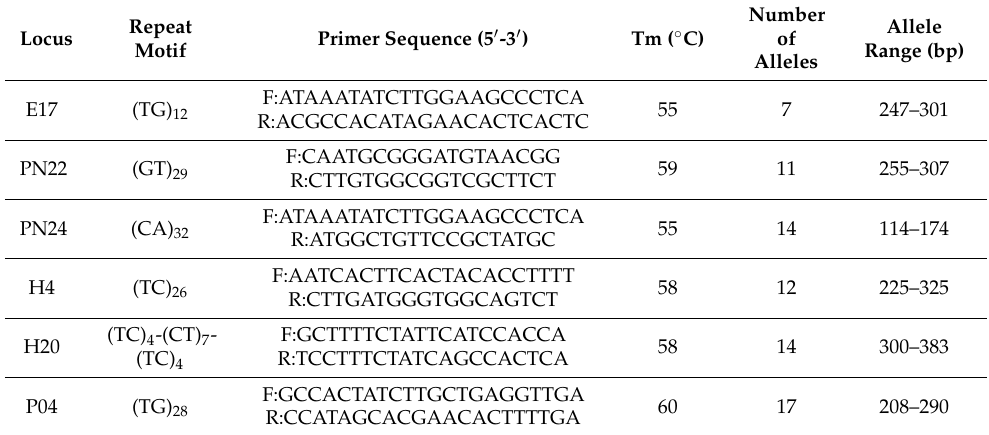
Table 2. Summary information of 6 microsatellite loci of P. trituberculatus